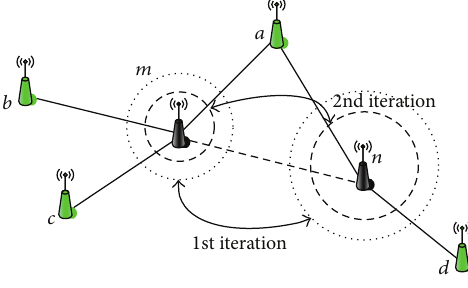
Figure 2: Iterative